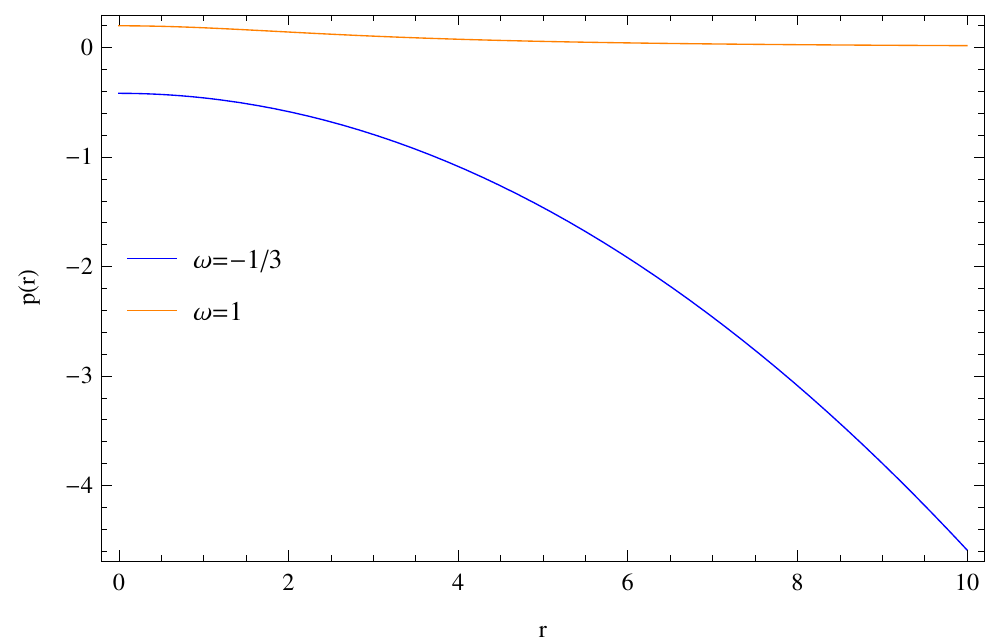
Figure 18. The pressure is plotted against the radial parameter r with the values of arbitrary constants C 3 = 2, C 4 = 0.001, C 5 =